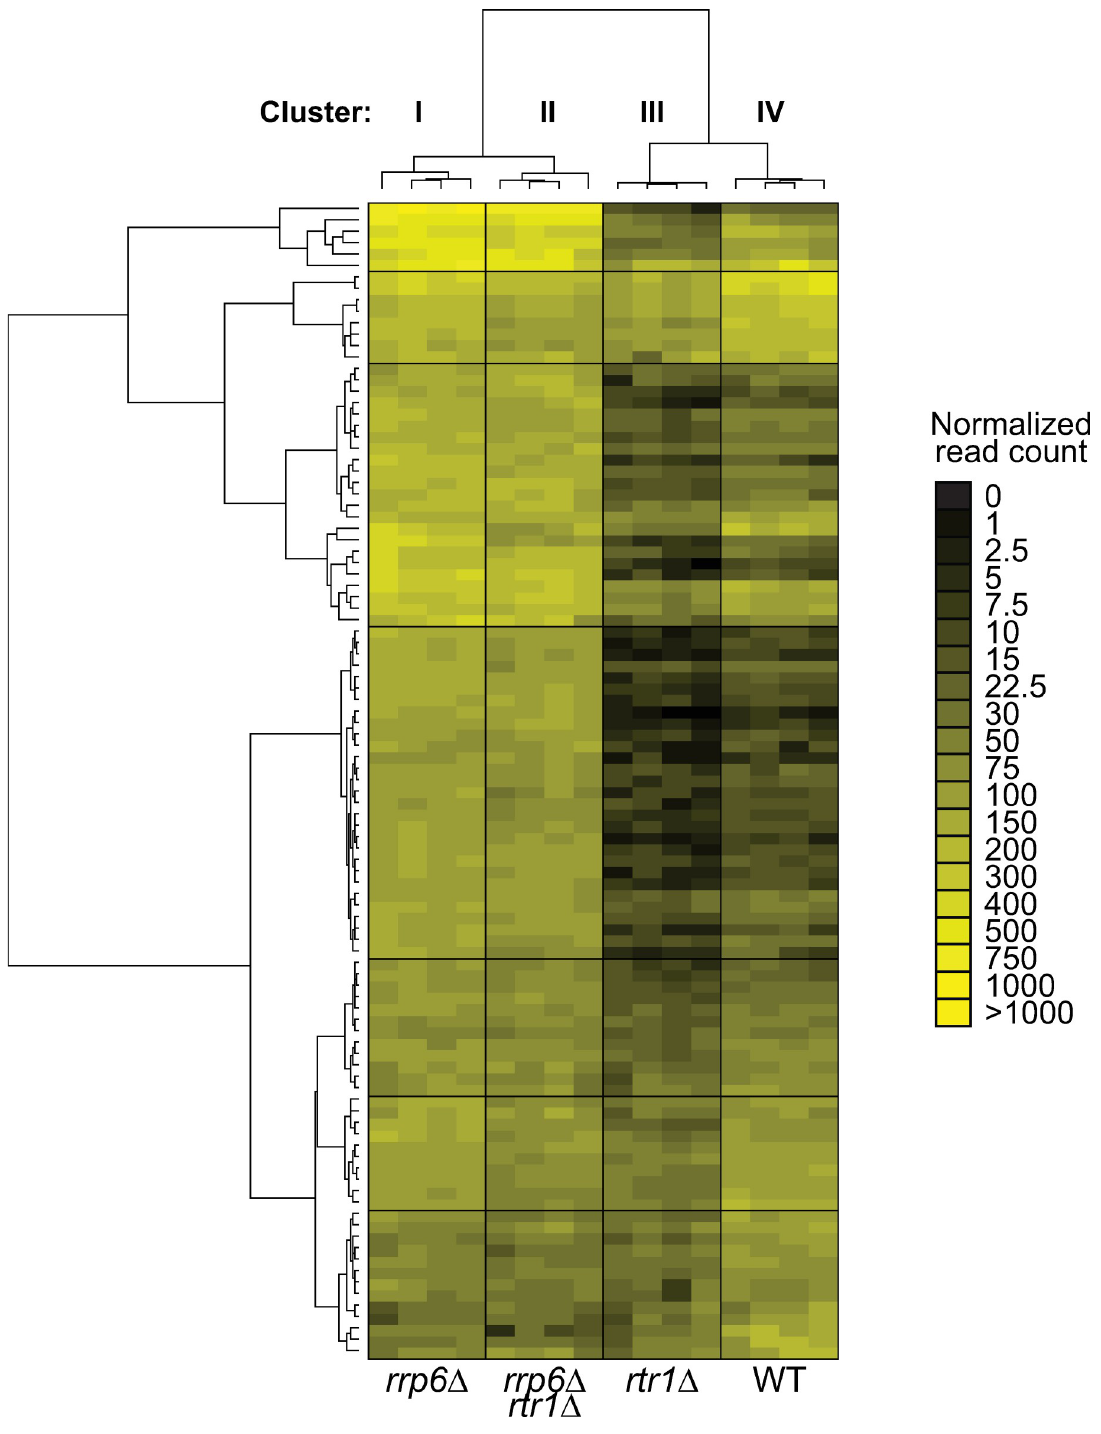
Fig 7. Abundance of antisense transcripts in RTR1/RRP6 double deletion strain phenocopies rrp6 Δ cells. Heat map of normalized expression values for ASTs in rtr1 Δ , rrp6 Δ , and rtr1 Δ rrp6 Δ compared to WT cells, according to the scale at the right. The ASTs shown were selected for clustering analysis based on their significant decreased expression relative to WT in RTR1 deletion cells. Unsupervised hierarchical clustering analysis was performed using normalized read count values for each biological replicate and genotype (n = 16). Each genotype clustered together illustrating a high degree of reproducibility between biological replicates with WT values groups as Cluster IV, rtr1 Δ values grouped as Cluster III, rtr1 Δ rrp6 Δ grouped as Cluster II, and rrp6 Δ grouped as Cluster I. Genotypes are also indicated at the bottom of the figure for